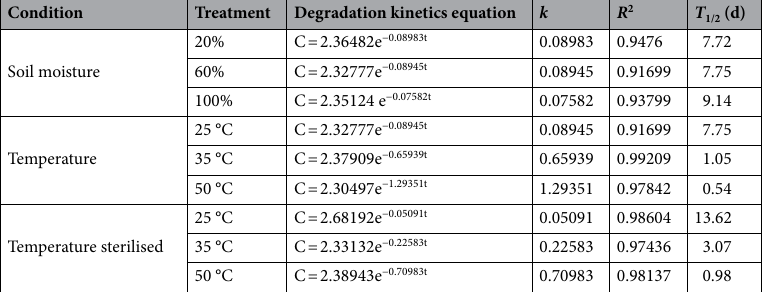
Table 10. Degradation kinetics parameters of propaquizafop in BS ginseng soil under different conditions.